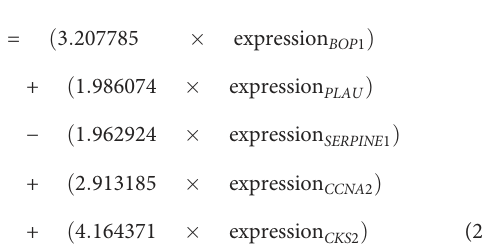
curve (AUC) was 0.773, 0.806, and 0.928 for 1, 3, and 5